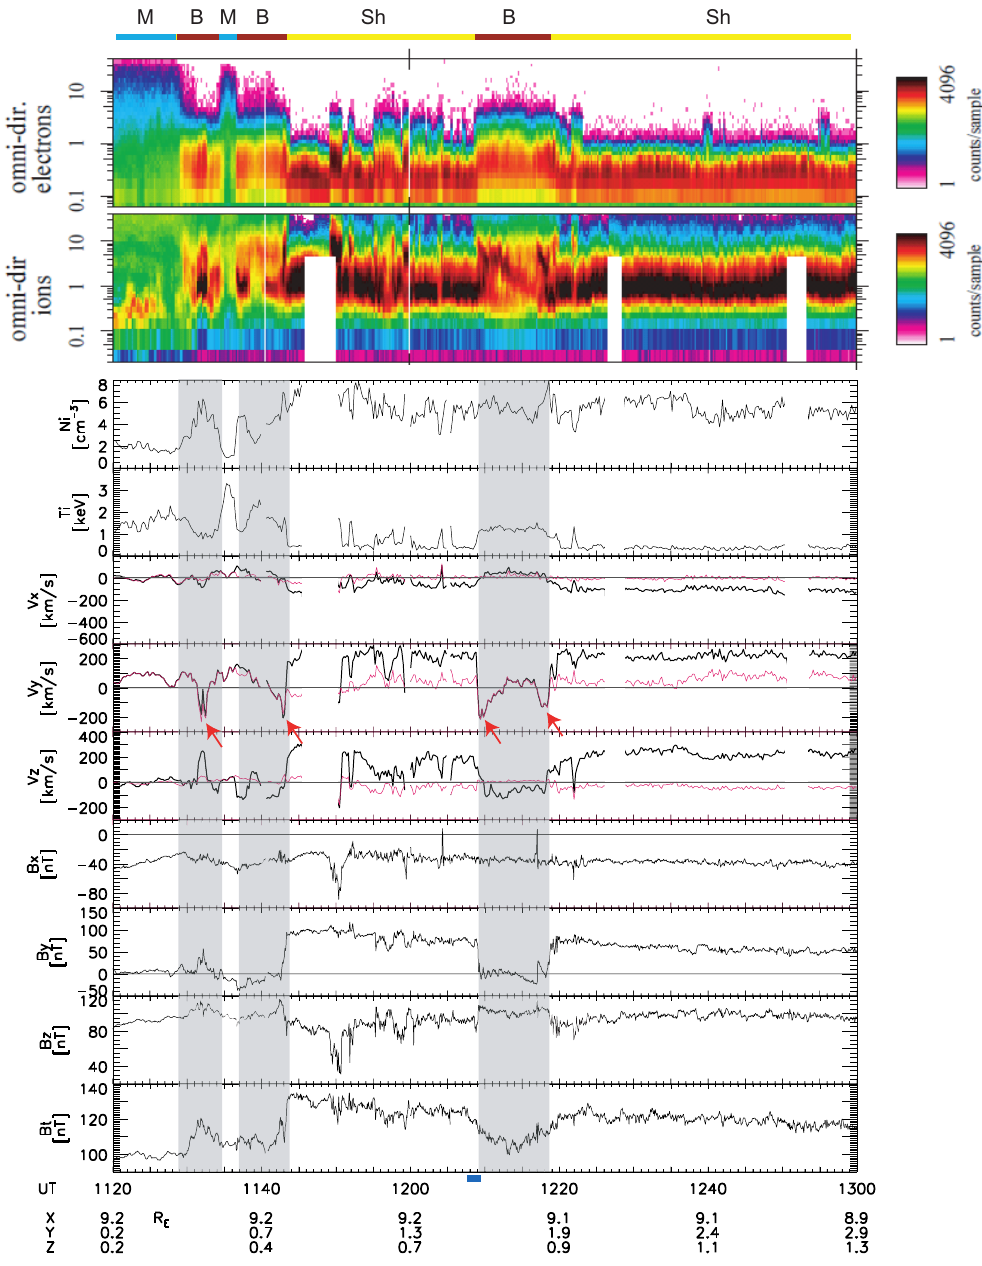
Fig. 2. E-t spectrograms of electrons (top panel) and of ions (second panel), ion moments calculated from LEP data, and the magnetic field. The scales are logarithmic for energy (ordinate) and count rates (colour). Periods of the magnetopause boundary layer are also hatched. At the outer edge of the layer, dawnward flows ( V y < 0) were observed (indicated by red arrows). The satellite position is described in GSM coordinates. Thinner magenta lines in the V x , V y , and V z panels are the components of the velocity perpendicular to the ambient magnetic field. The bar on the top roughly indicates the region in which Geotail was located; the light blue, yellow, and maroon mean the magnetosphere (M), the magnetosheath (Sh), and the boundary layer (B), respectively.